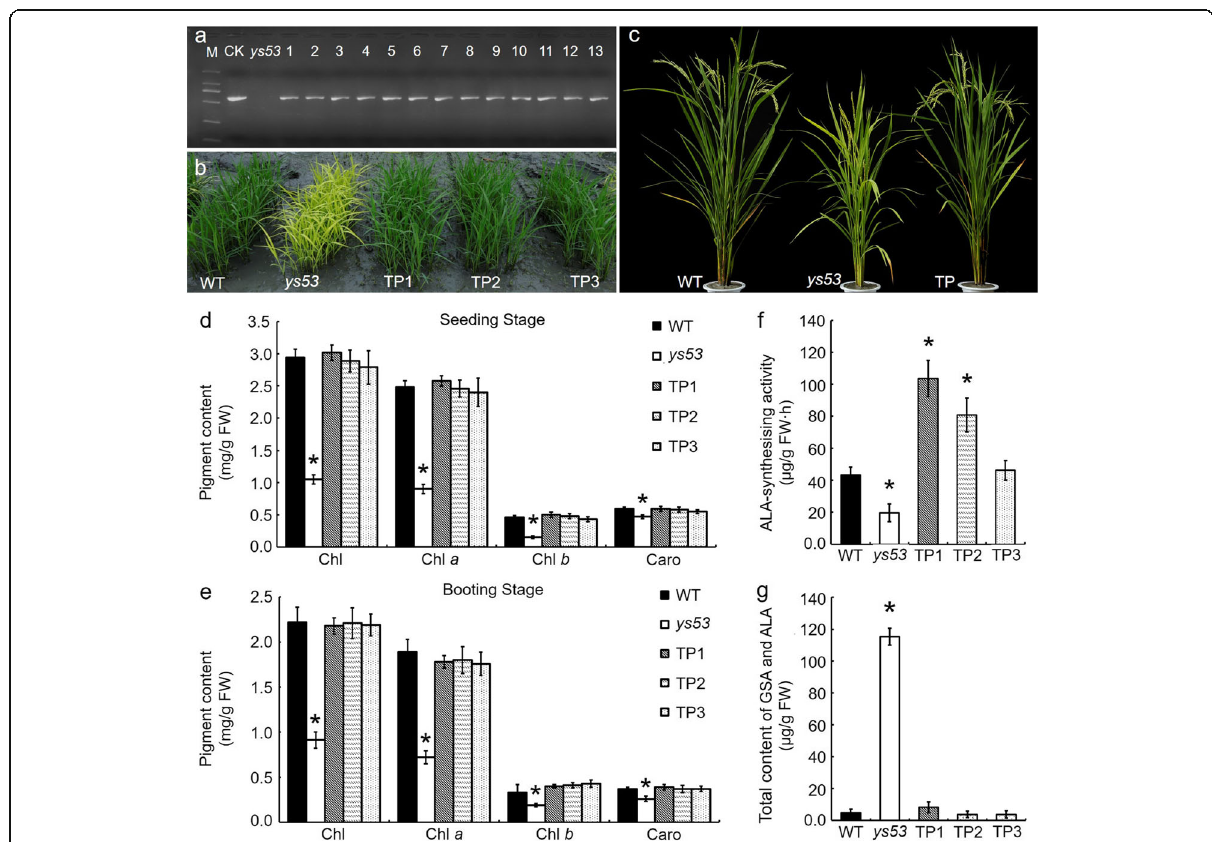
Fig. 5 Complementation of the ys53 mutant by OsGSAM gene. a Identification of transgenic lines by PCR. M, DL-2000 Marker; CK, pC2300- OsGSA plasmid (PCR positive control); ys53 , ys53 mutant (PCR negative control); 1 – 13, positive transgenic plants. b Phenotypes of ys53 mutant, the wild type (WT), and the positive transgenic plants (TPs) at seedling stage. c Phenotypes of ys53 , WT, and TPs at grain filling stage. d Photosynthetic pigment contents (in mg g fresh weight − 1 ) of ys53 , WT, and TPs in leaves of four-week-old seedlings. e Photosynthetic pigment contents (in mg g fresh weight − 1 ) in leaves of ys53 , WT, and TPs at booting stage. f and g ALA-synthesising activity of rice seedlings, and total content of GSA and ALA in rice leaves at seedling stage, respectively, which were detected according to the methods as Fig. 4. Data are mean ± SD ( n = 3). Error bars represent SDs of three independent experiments. * indicate statistically significant differences compared with WT at P <